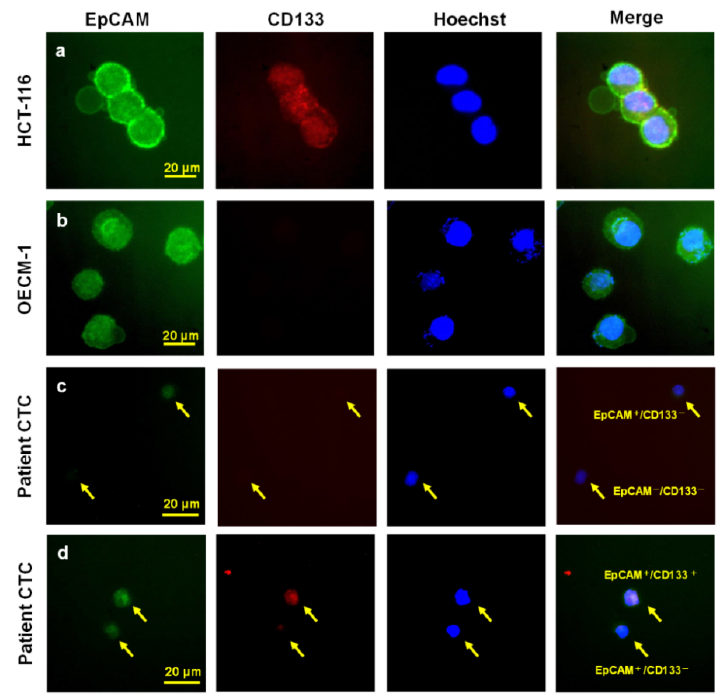
Figure 2. Detecting circulating tumor cells (CTCs) and circulating cancer stem-like cells (cCSCs) using immunofluorescence (Patient No.16 and Patient No.21). ( a ) HCT116 as the demonstrated cell line for EpCAM + /CD133 + cells. ( b ) The OECM-1 as the demonstrated cell line for EpCAM + /CD133 − cells. ( c ) In Patient No. 16, the image showed the EpCAM + /CD133 − and EpCAM − /CD133 − CTCs. ( d ) In Patient No. 21, the image showed the EpCAM + /CD133 + and EpCAM + /CD133 − CTCs.